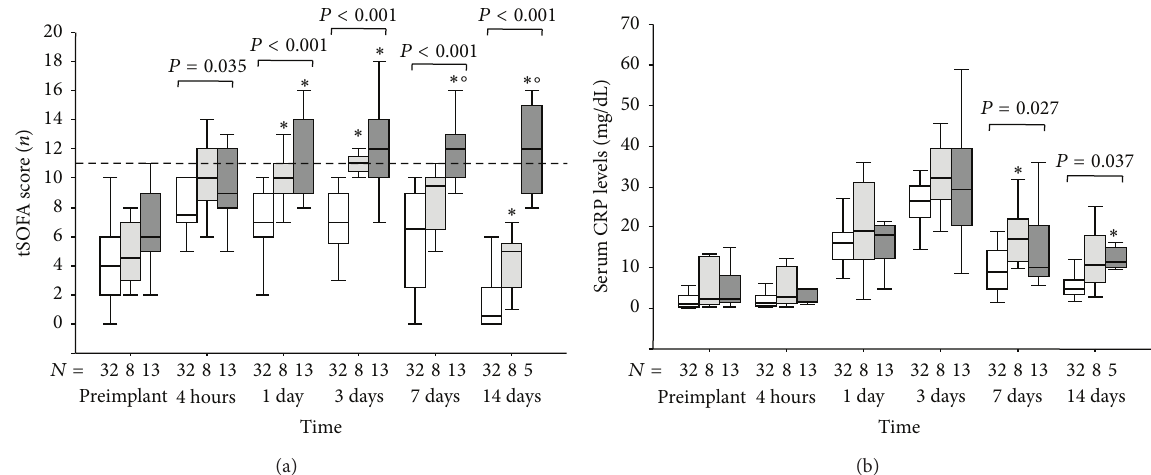
Figure 1: (a) Time course of the t-SOFA score and (b) CRP levels in patients that experienced postoperative maximal tSOFA score < 11 (group A: empty box-plots), and patients with postoperative maximal tSOFA score ≥ 11, with positive (group B: light gray box-plots) or negative (group C: dark gray box-plots) 3-month outcome. The tSOFA score ≥ 11 is pointed out by a dashed line. 𝑃 values are for differences among groups at each time-point by Kruskall-Wallis text. ∗ 𝑃 < 0.05 versus group A by Mann-Whitney text corrected by Bonferroni. ∘ 𝑃 < 0.05 versus group B by Mann-Whitney text corrected by